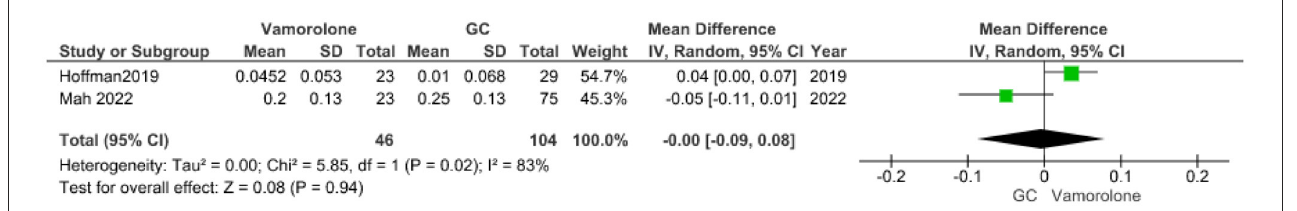
FIGURE5 TTSTAND outcome vamorolone vs. glucocorticoids.